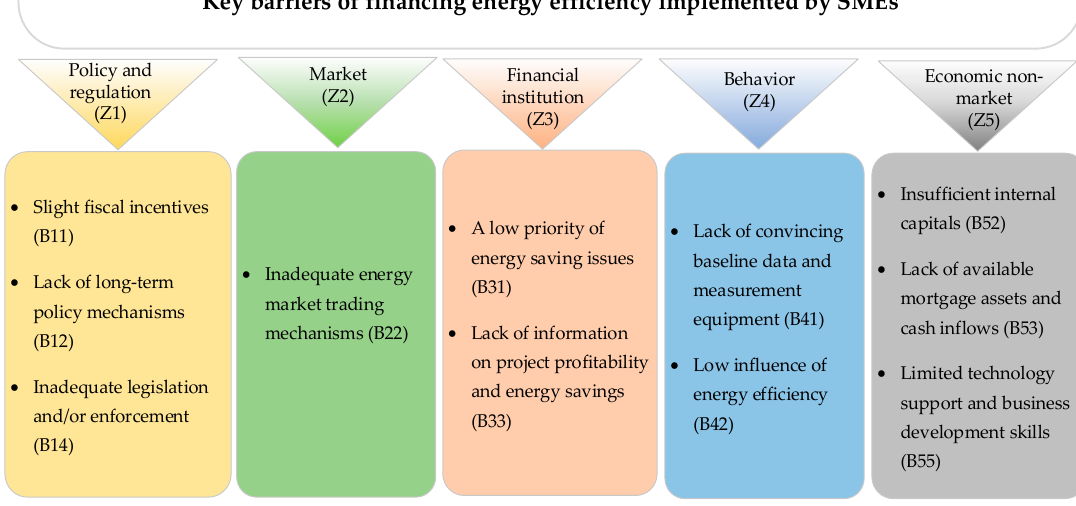
Figure 11. A list of key financial barriers.